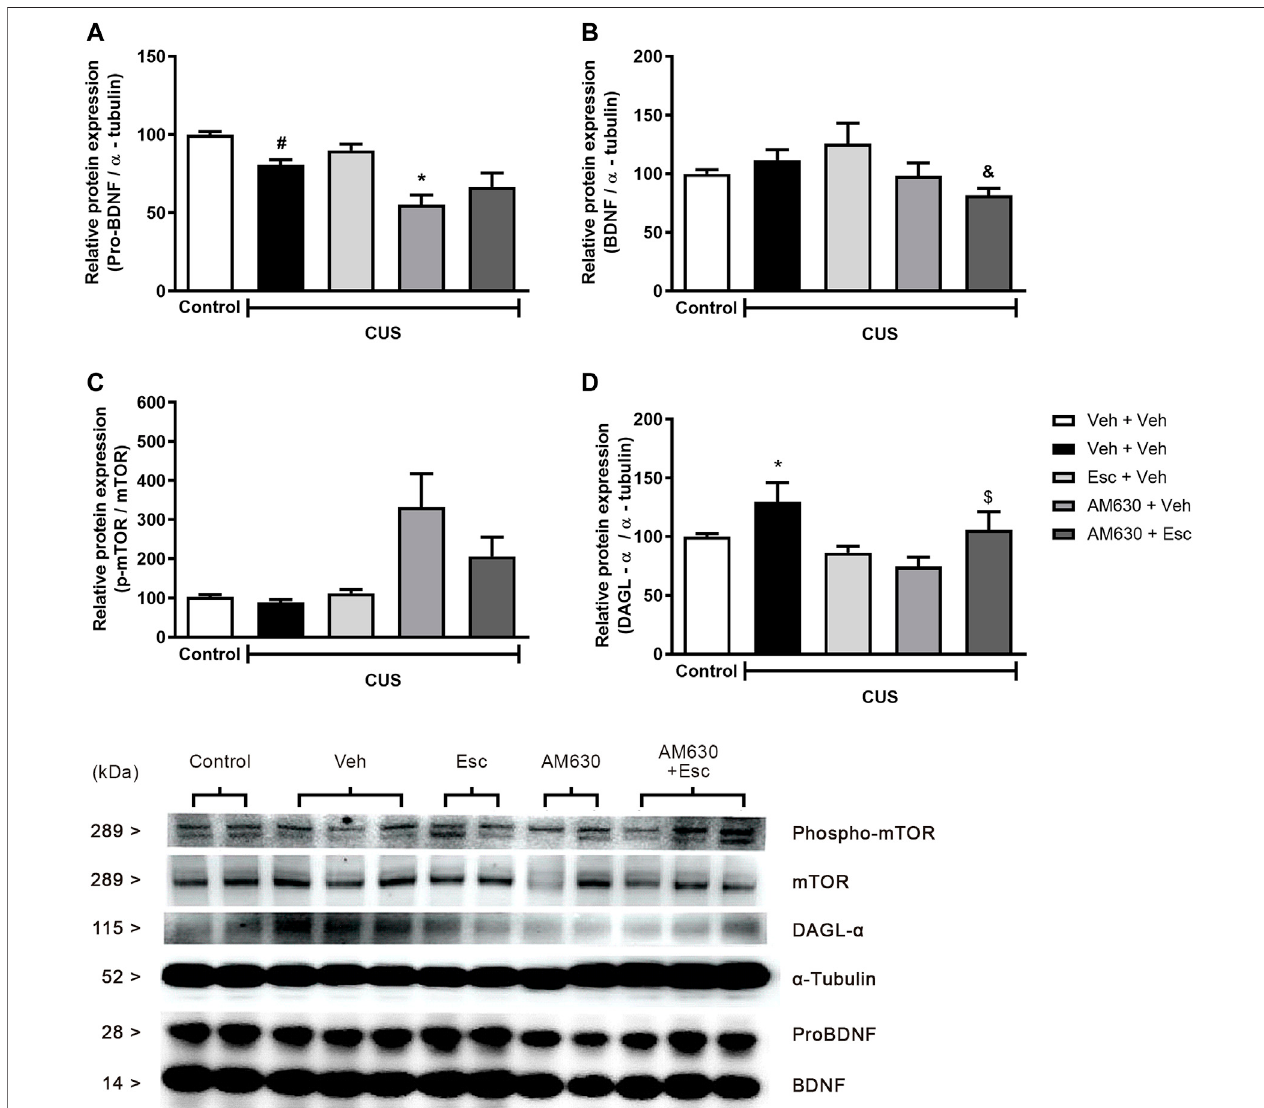
FIGURE4| Relativehippocampal proteinexpression andcorticosteronelevelsofstressedmicetreatedwithESCincombinationornotwithAM630.Figureshows the expression of pro-BDNF (A) . mature BDNF (B) . phospho-mTOR (C) and DAGL (D) . Representatives of western blot membranes are detailed in the image. Groups were: non-stressed/saline/saline ( n (cid:1) 5); CUS/saline/saline ( n (cid:1) 5); CUS/AM630/saline ( n (cid:1) 4); CUS/saline/ESC ( n (cid:1) 4); and CUS/AM630/ESC ( n (cid:1) 5). ANOVA-two was employed and differences were considered statistically signi fi cant when p < 0,05. N (cid:1) 4-5/group. (# relative to NS/Veh + Veh; * relative to CUS/Veh + Veh and & relative to the CUS-AM630 compared to CUS-AM630 +